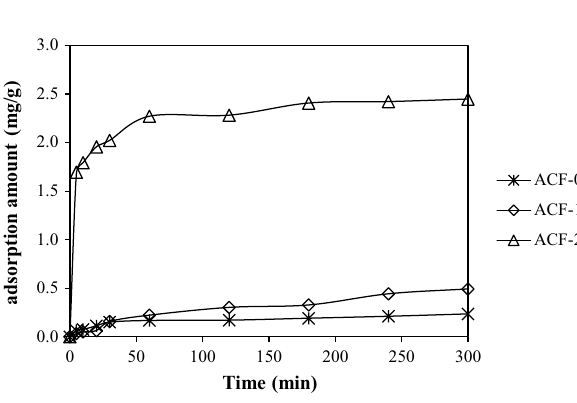
Fig. 2 SEM images of a ACF-0, b ACF-1, c ACF-2, d EDAX spectra of ACF-2